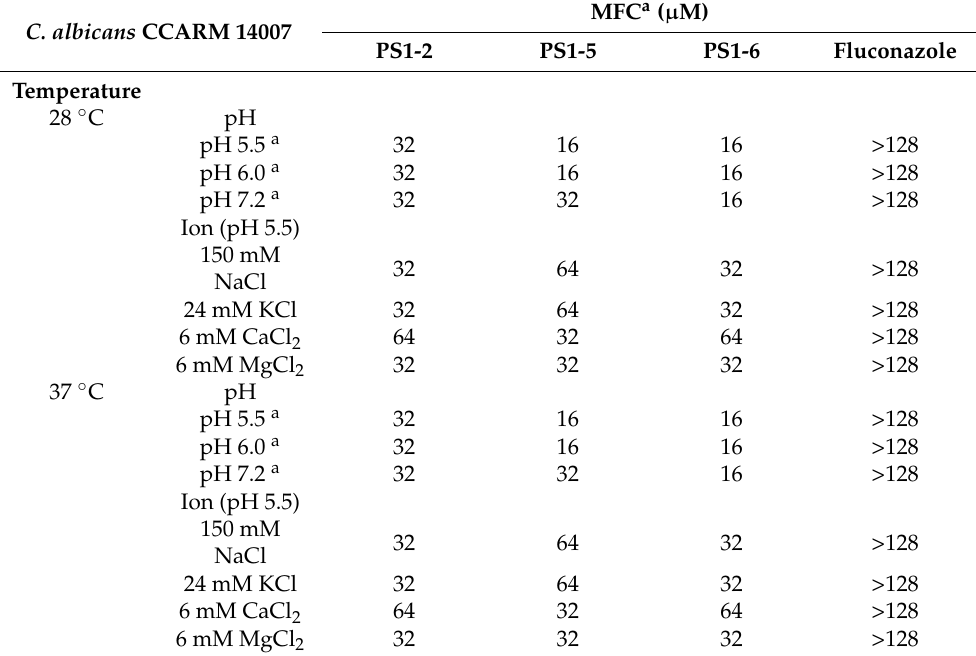
Table 1. Candidacidal activity of PS1-2, PS1-5, PS1-6 peptide, and fluconazole against Candida albicans CCARM 14007 (fluconazole-resistant strain) in various buffer